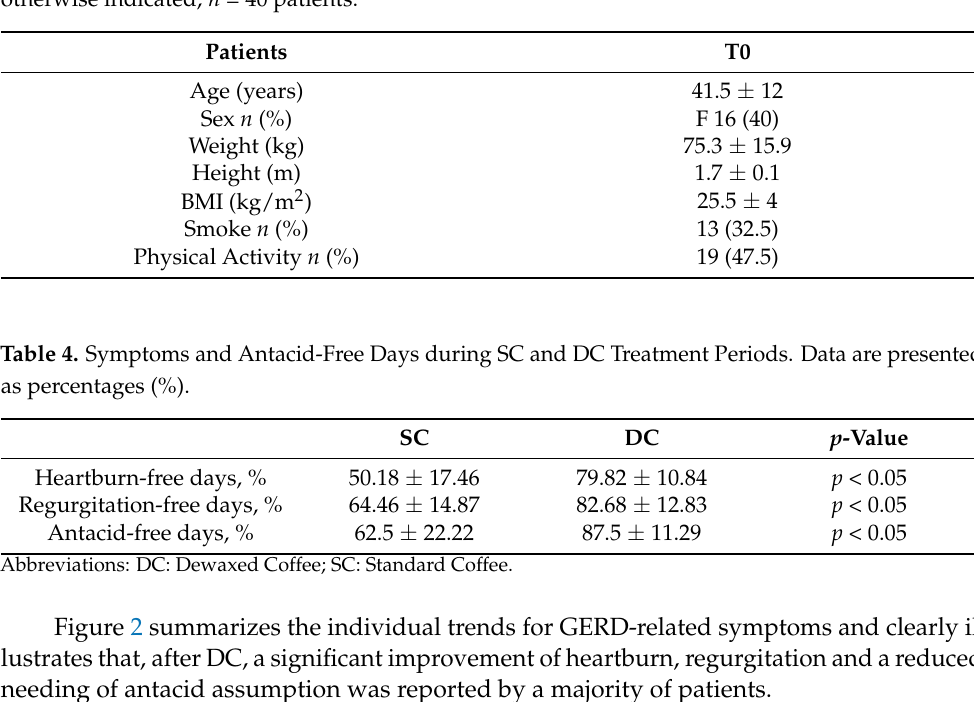
Table 3. Demographic and baseline characteristics of patients. Values are means ± SD unless otherwise indicated; n = 40 patients.